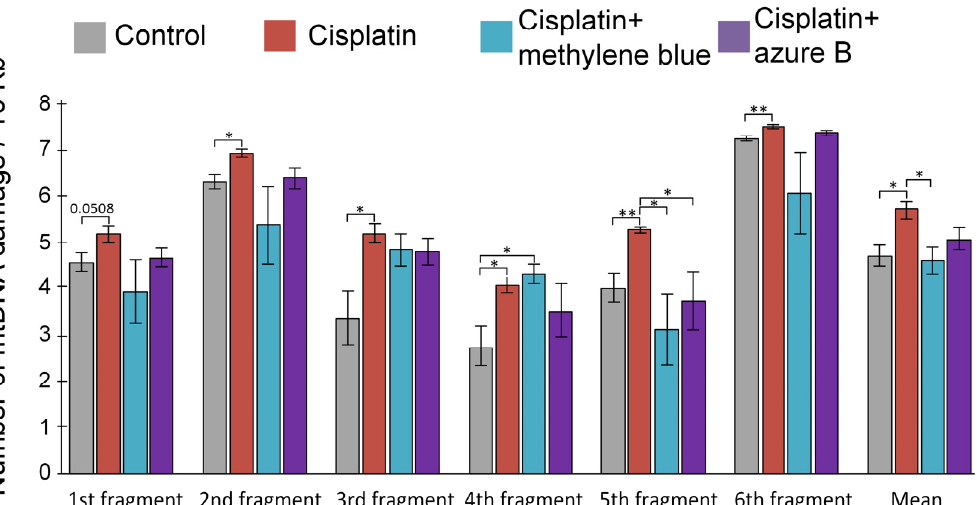
Figure 4. Impact of cisplatin injections and methylene blue and azure B treatments on the amount of mtDNA damage in kidneys. Differences are statistically significant: * p < 0.05, ** p < 0.01 (Mann–Whitney test). The results are expressed as means ± SEM. Control ( n = 10), cisplatin ( n = 6), cisplatin + methylene blue ( n = 8), cisplatin + azure B ( n = 8). In the 1st, 2nd, 3rd, and 9th fragments, cisplatin injections induced an increase in the number of mtDNA damage ( p = 0.05 for the 1st fragment, p < 0.05 for the 2nd and 3rd fragments, p < 0.01 for 9th fragment). In these fragments, pre-treatment with